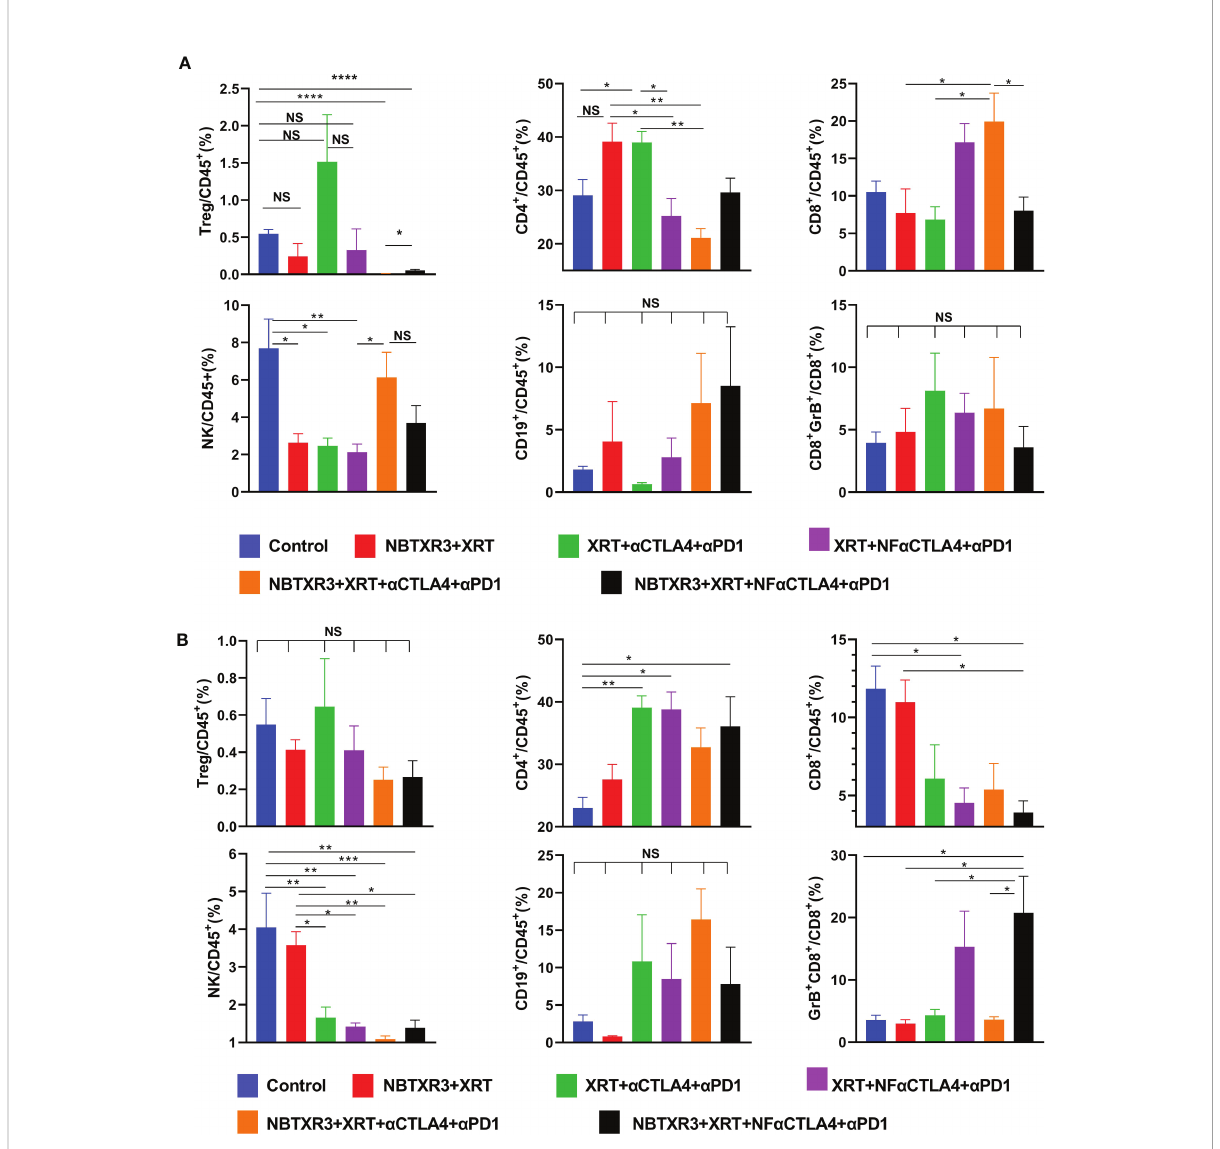
FIGURE 2 NF- a CTLA4 and NBTXR3-mediated immunoradiotherapy signi fi cantly reduces Tregs and promotes CD8 + T cell activation in the tumor immune microenvironment. (A) Percentages of various immune cells in the primary tumor. (B) Percentages of various immune cells in the secondary tumors. The mice (n=5) were treated with various combination therapies as indicated in Figure 1A, and both primary and secondary tumors were harvested on day 16. Immune cell populations, including CD3 + CD4 + FoxP3 + (Tregs), CD3 + CD4 + T cells, CD3 + CD8 + T cells, CD3 - CD49b + (NK cells), CD3 - CD19 + (B cells) and the Granzyme B + (Gzm B + ) CD3 + CD8 + T cells subpopulation, were analyzed by fl ow cytometry. Data are expressed as means± SEM. P<0.05 was considered statistically signi fi cant. *P<0.05, **P<0.01, ***P<0.001, ****P<0.0001, NS, not signi fi